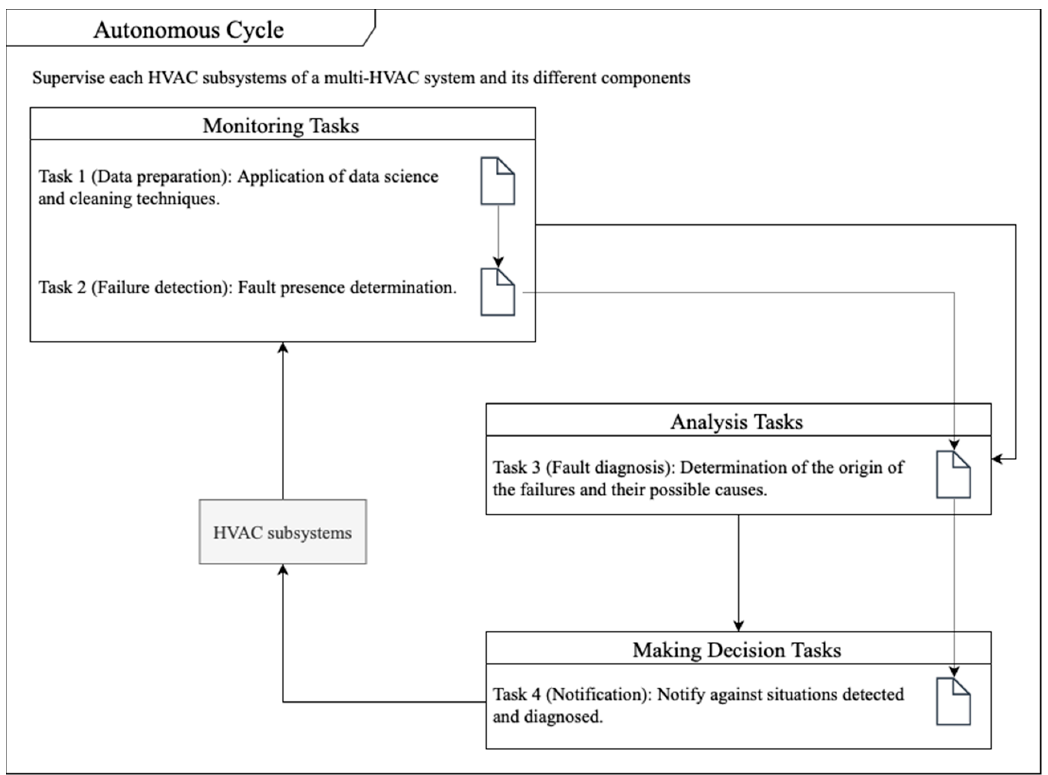
Figure 1. ACODAT-based supervision for HVAC systems.